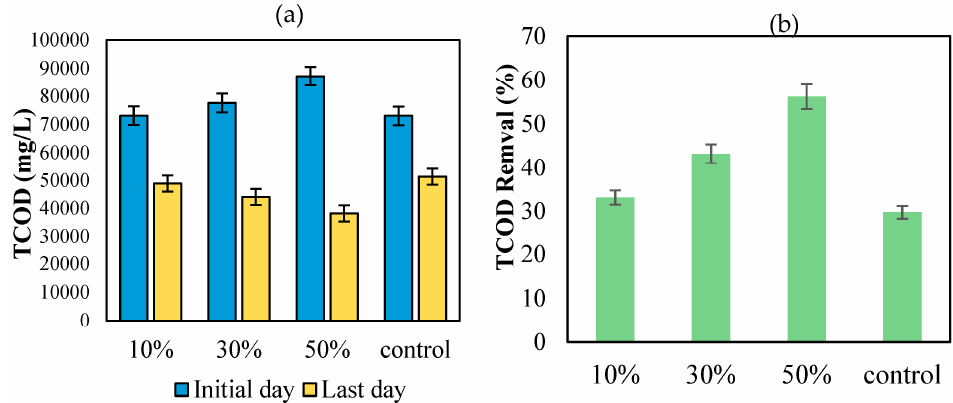
Figure 14. Total COD concentration in the digesters on the initial and last day ( a ) and percentage of TCOD removal of the considered digester ( b ).